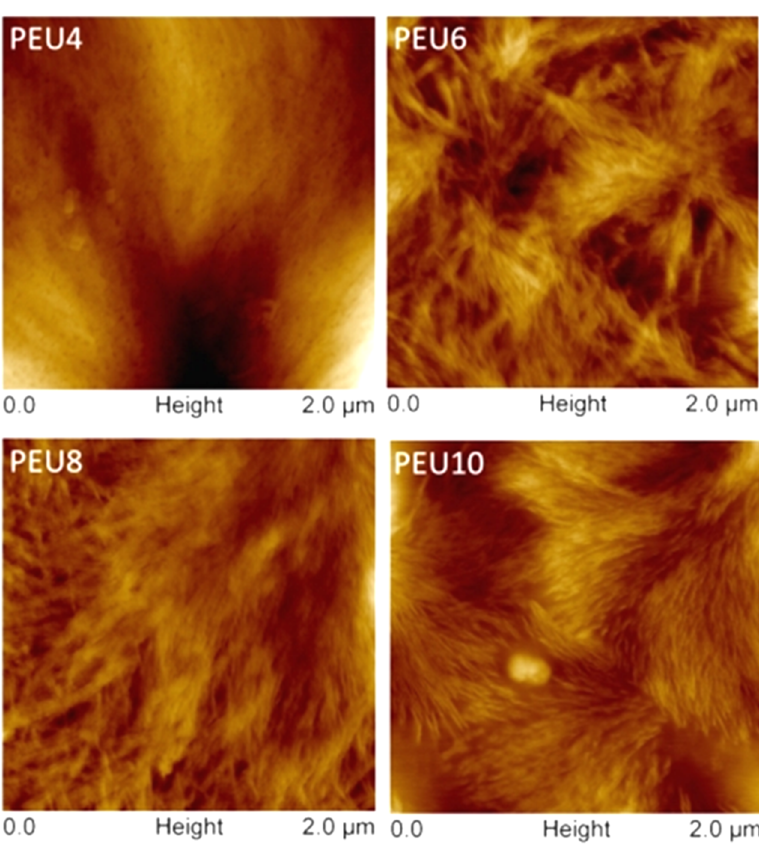
Figure 10. Height images of PEU (Size: 2 µ m).